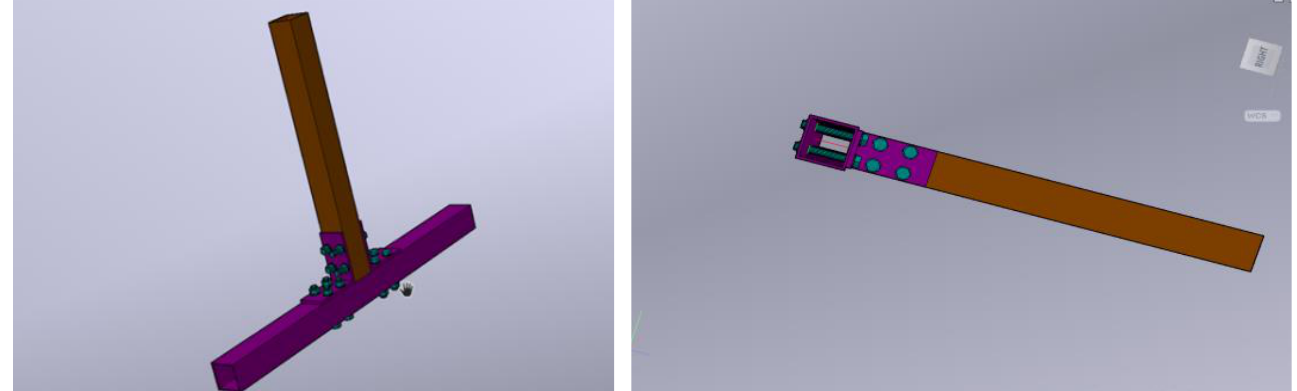
Figure 17. Creation of connection profile using Autodesk advanced steel software.